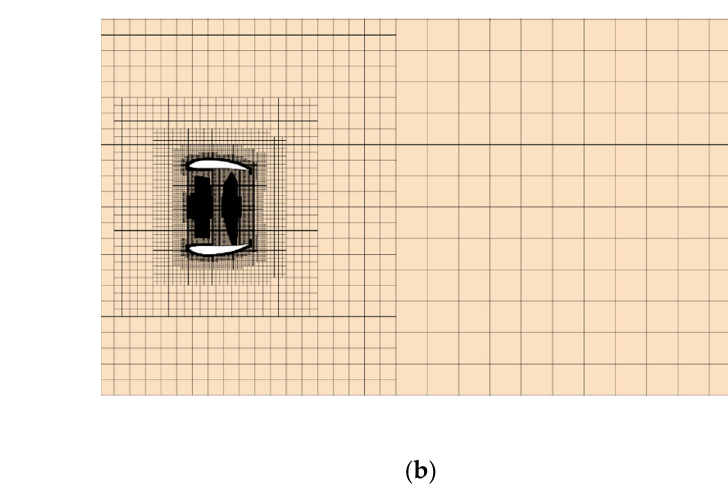
Figure 12. Schematic diagram of X = 0 and Y = 0 mesh section: ( a ) X = 0 grid diagram; ( b ) Y = 0 grid diagram.